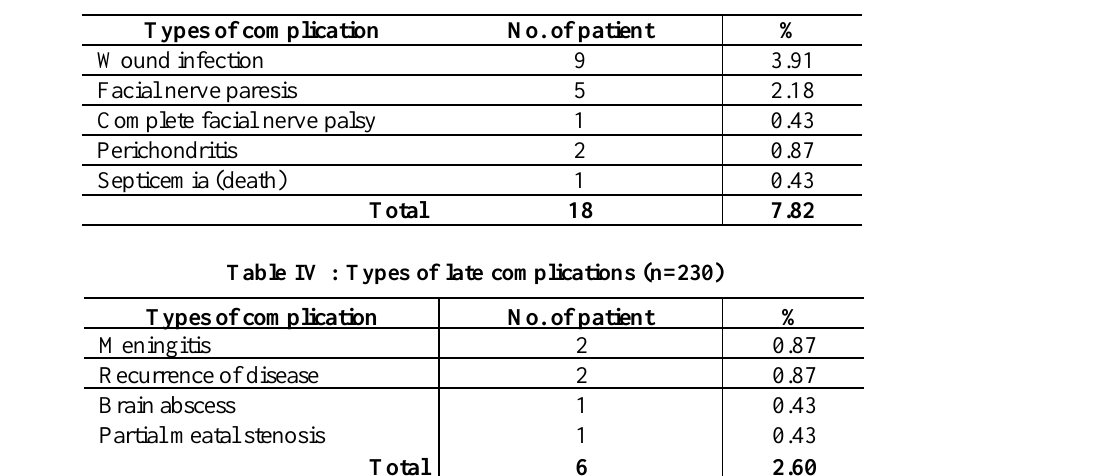
Table III : Types of early complications